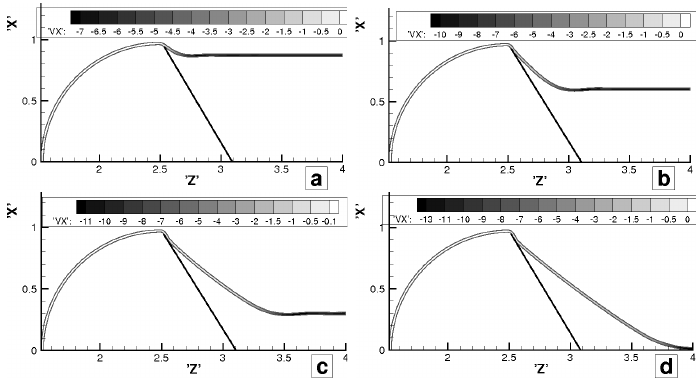
Figure 8. The thermoelastic liner positions for different times ( t = 0 . 048; 0.072; 0.105; 0.141